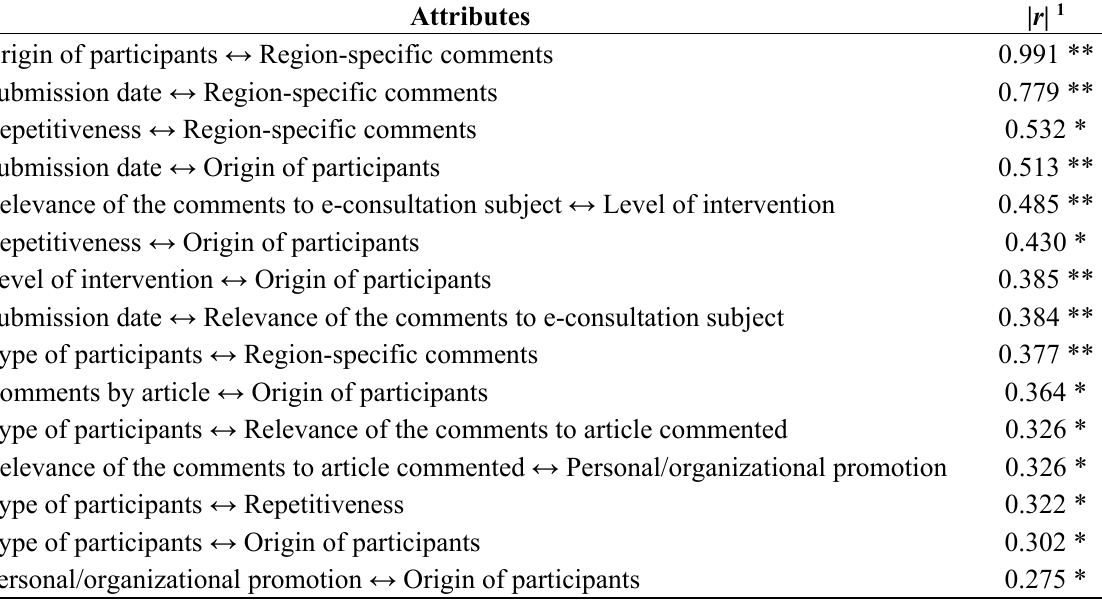
Table 3. Statistically significant correlations among specific attributes of